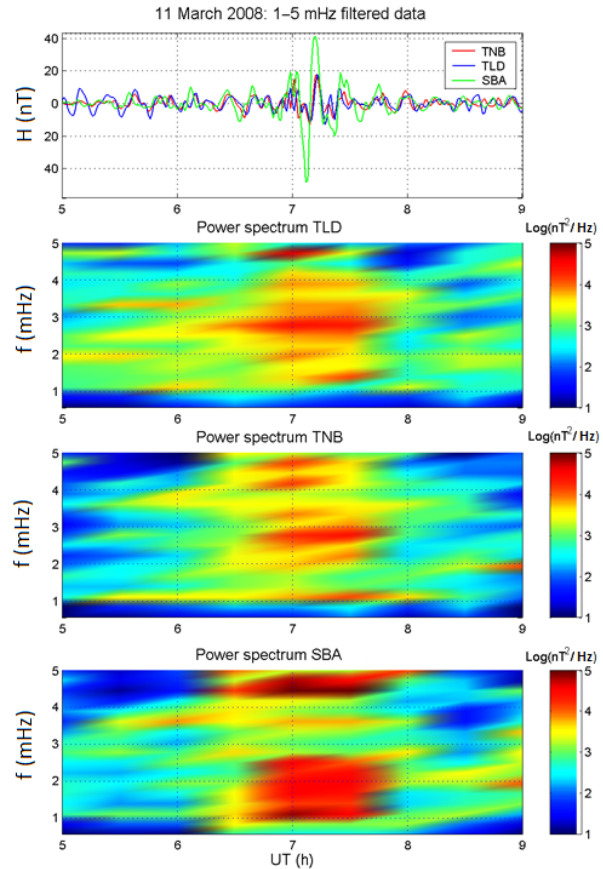
Figure 10. From top: variations in the geomagnetic field H compo- nent filtered in the 1–5mHz frequency range and dynamical power spectra for the event on 11 March